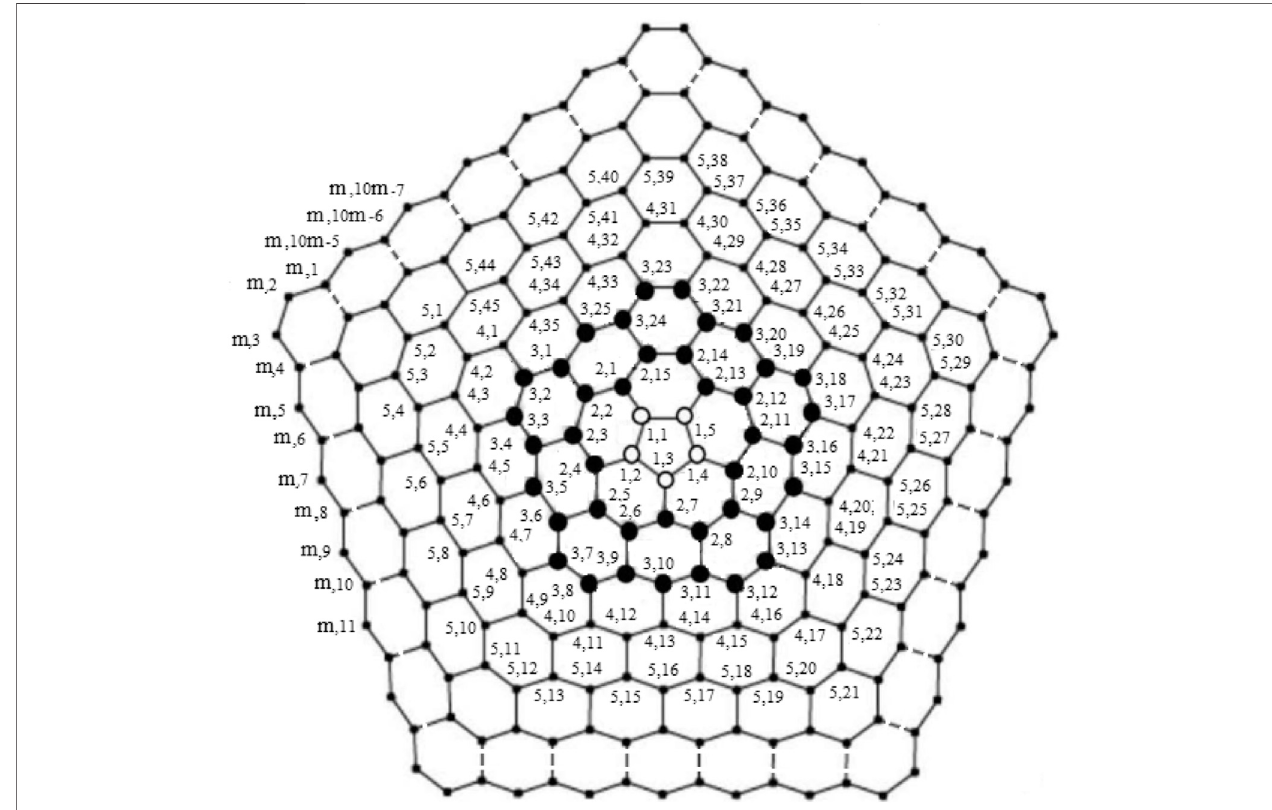
as its center. Along with it, a two-dimensional planar graph of a 1- PCNC is constructed, with carbon atoms representing vertices and bonds representing edges between them (see Figure 2 ).